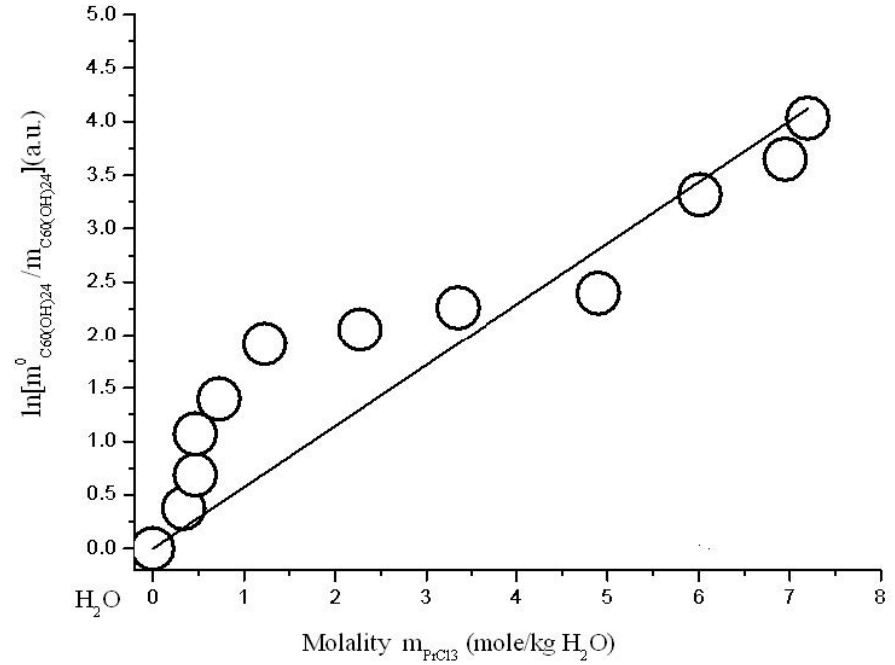
Figure 11. Branch of crystallization C 60 (OH) 24 *18H 2 O in the diagram of solubility in ternary system С 60 (ОН) 24 —PrCl 3 — H 2 O at 25 °C (strict line -s calculation according to Sechenov equation SE-1 (4)).